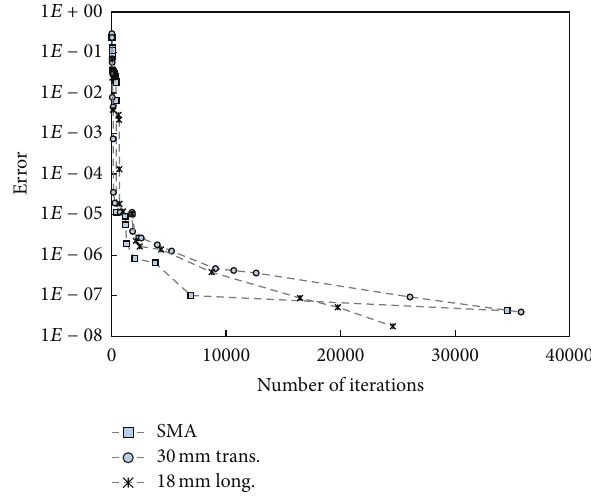
) in dB for the WA